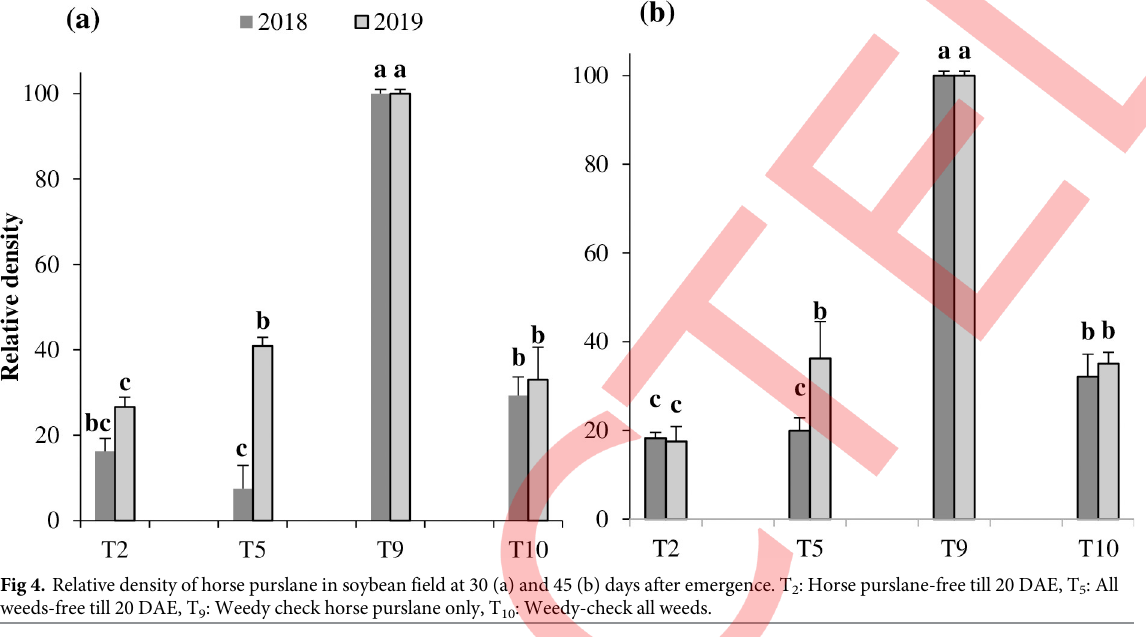
Fig 4. Relative density of horse purslane in soybean field at 30 (a) and 45 (b) days after emergence. T 2 : Horse purslane-free till 20 DAE, T 5 : All weeds-free till 20 DAE, T 9 : Weedy check horse purslane only, T 10 : Weedy-check all weeds.